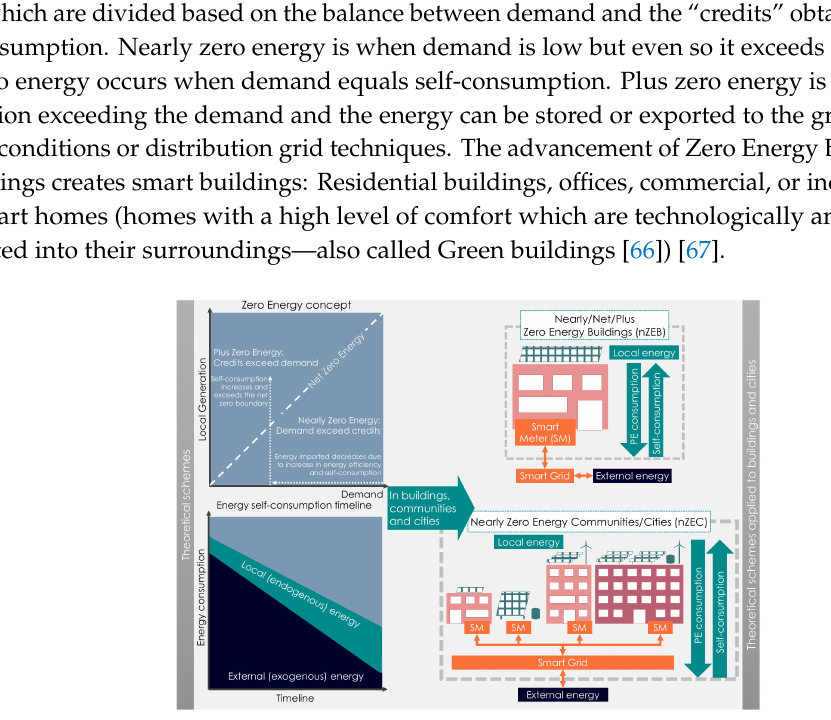
Figure 6. Zero energy concept in buildings and